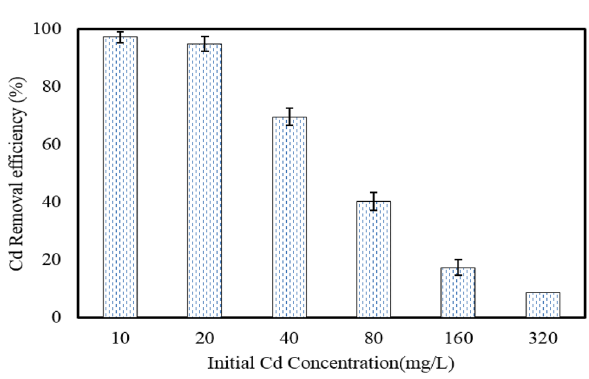
Figure 7. The effect of initial concentration of Cd on its removal by the MBA nano-hybrid (pH = 7.0, adsorbent = 1.0 g/L, temperature = 25 °C, time = 60